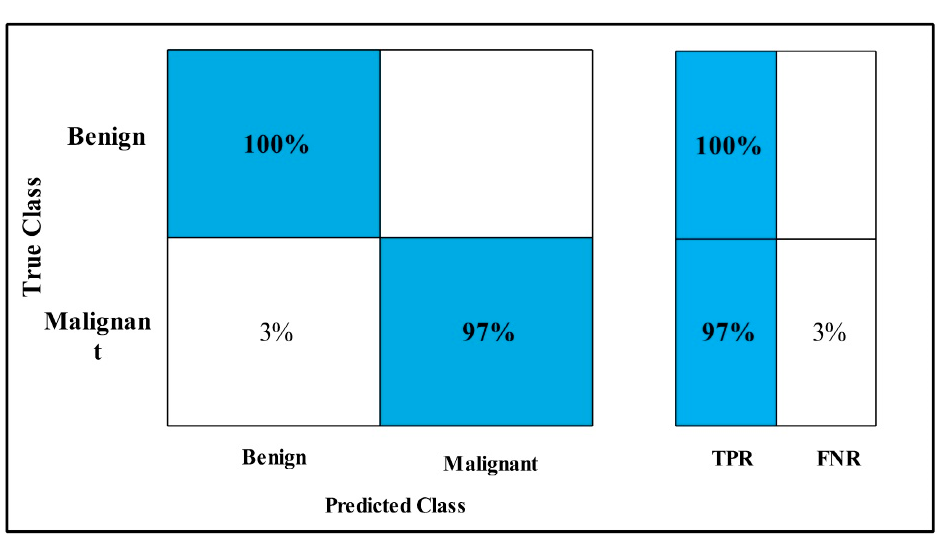
Table 16. Classification results using MEWOA on Fine-tuned MobilenetV2 deep features for